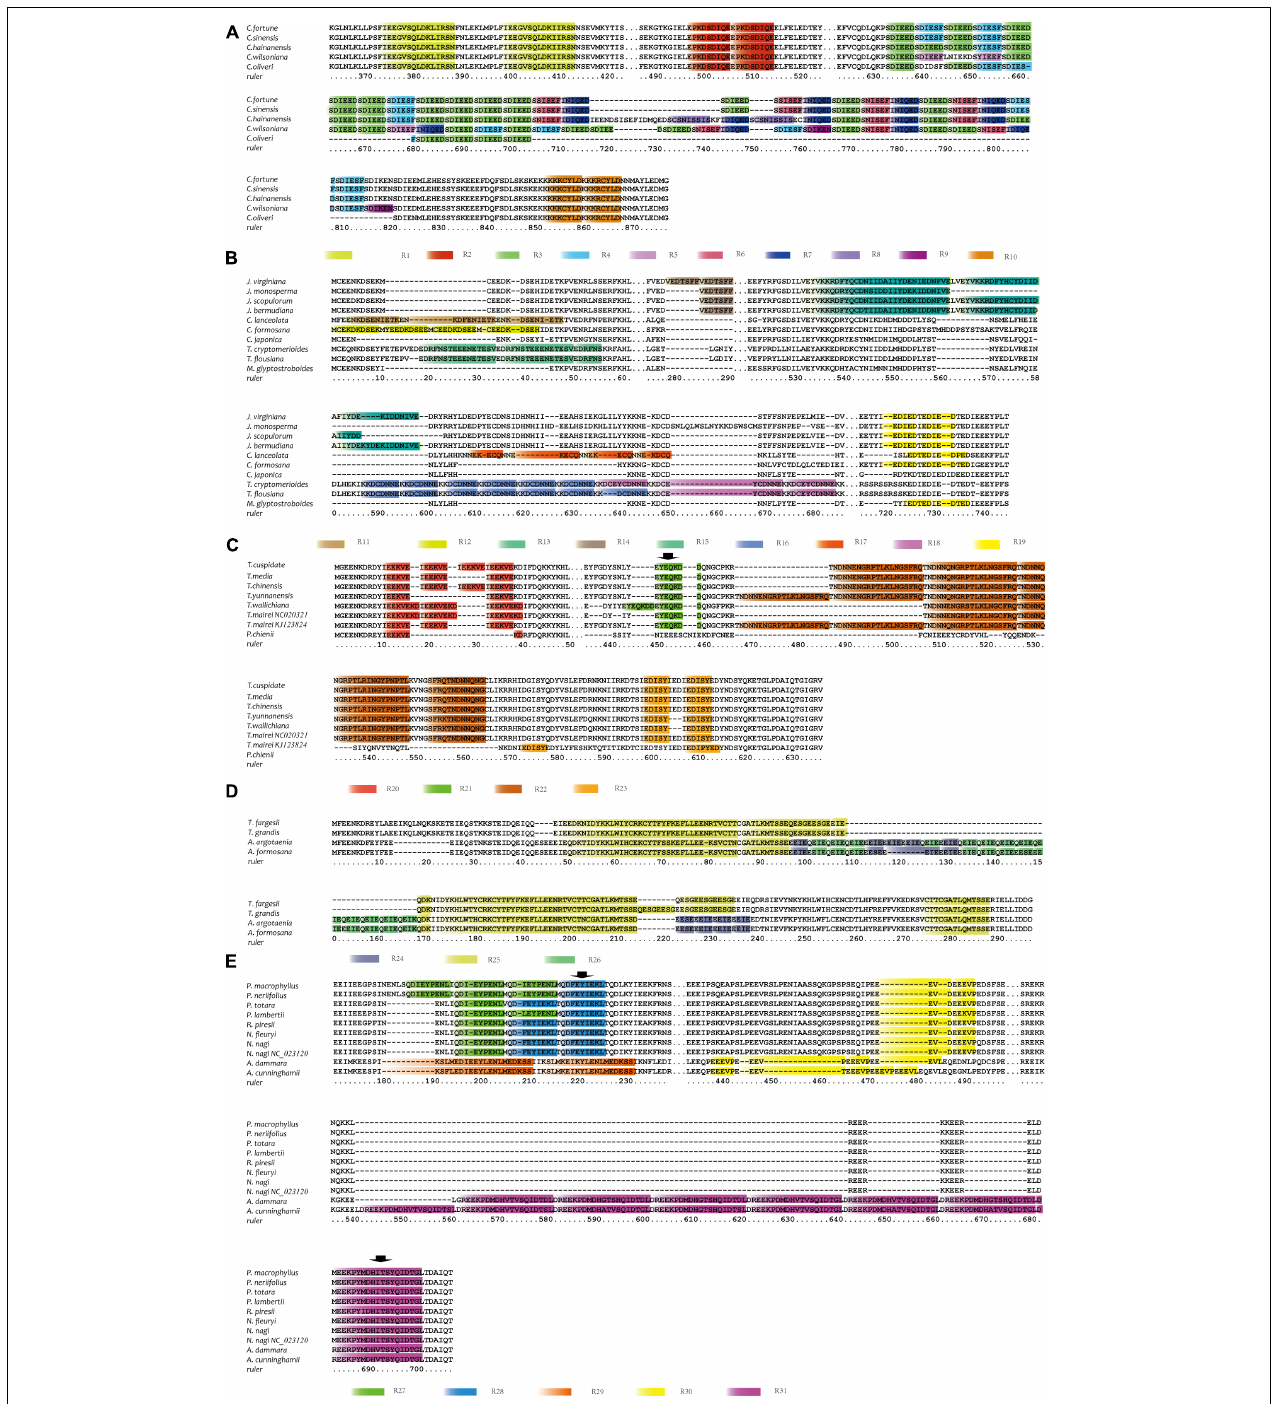
FIGURE 1 | The repetitive elements of accD gene in five groups of species. Sequence alignments were performed individually in each group using MEGA. (A) The alignment of amino acid sequences of ACCD protein from five Cephalotaxaceae species. The figure only shows the regions from 364 to 422 and 488 to 876. (B) The alignment of amino acid sequences of ACCD protein from ten Cupressaceae species. The figure only shows the regions from 1 to 61, 276 to 290, and 522 to 744. (C) The alignment of amino acid sequences of ACCD protein from seven Taxus species and P. chienii . The figure only shows the regions from 1 to 50 and 436 to 636. (D) The alignment of amino acid sequences of ACCD protein from two Torreya and two Amentotaxus species. The figure only shows the regions from 1 to 297. (E) The alignment of amino acid sequences of ACCD protein from eight Podocarpaceae and two Araucariaceae species. The figure only shows the regions from 171 to 237, 434 to 497 and 530 to 707. Different repetitive elements were marked with different colored boxes. The arrows indicate the repetitive elements which has only one copy. The spacer between two fragments was divided by three dots.